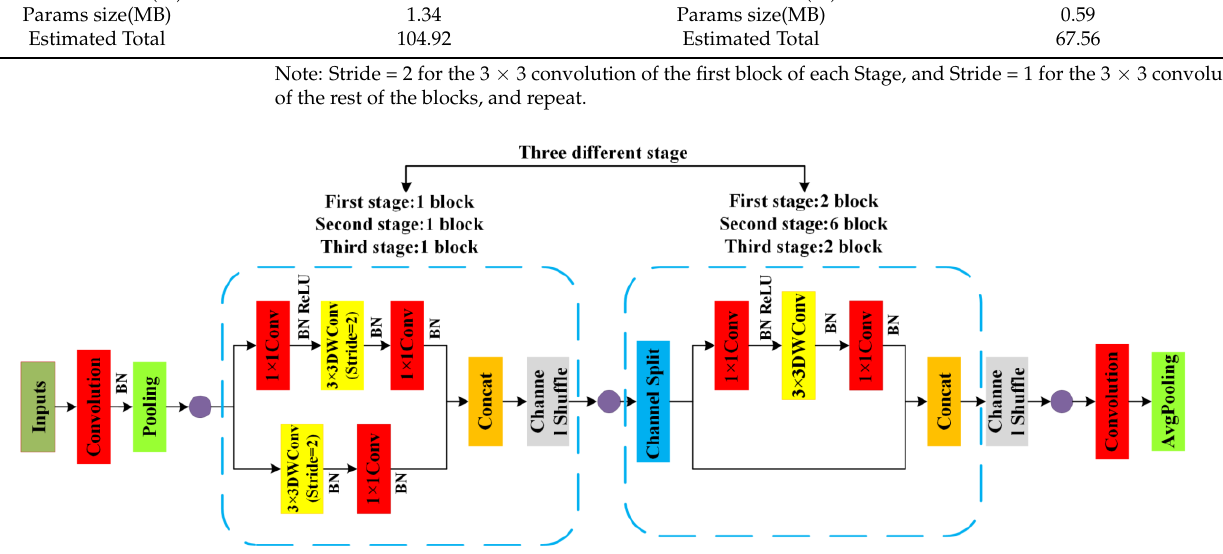
Figure 1. ShuffleNet v2.3 network structure.